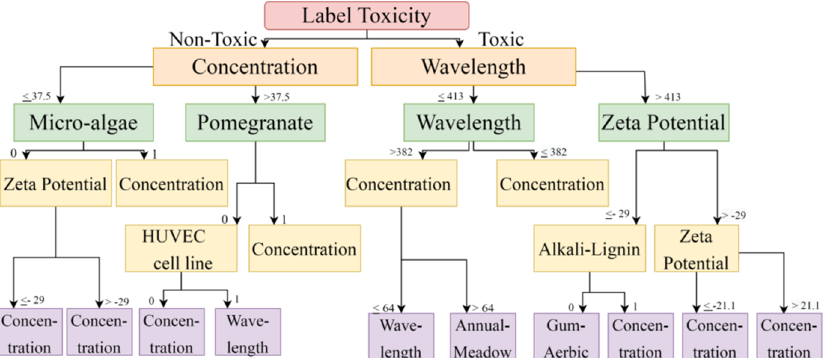
Figure 3. Toxicity is vital in predicting cell viability using a Decision Tree. When solutions are non-toxic, it depends upon concentration; when solutions are toxic, it depends upon wavelength.